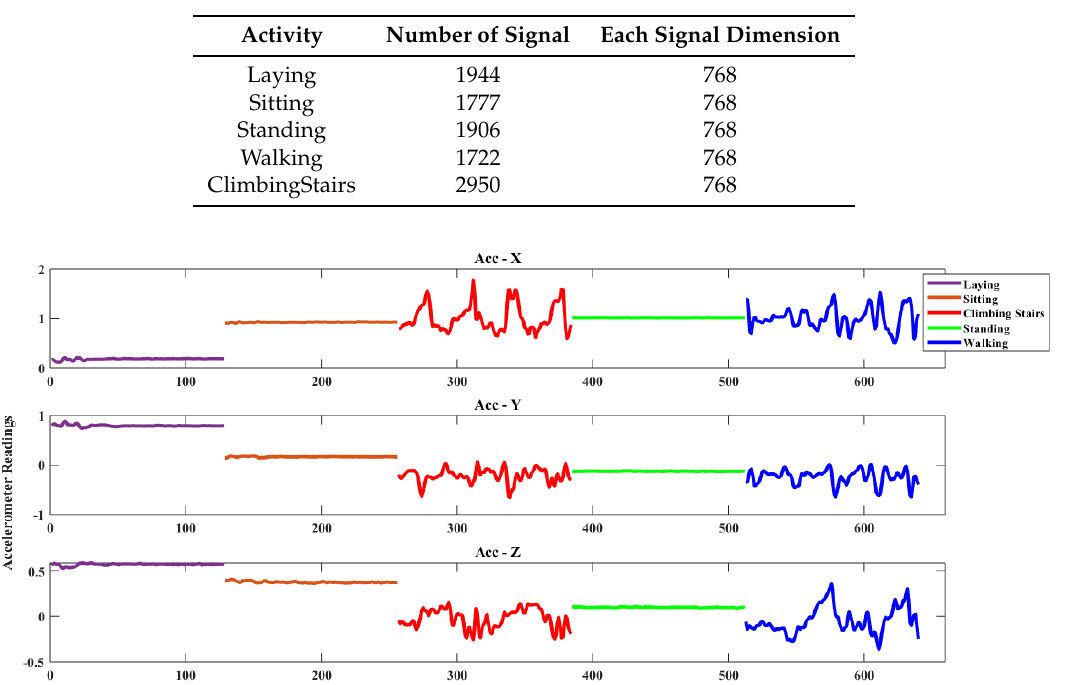
Table 1. Class wise data description of UCI-HAR dataset.